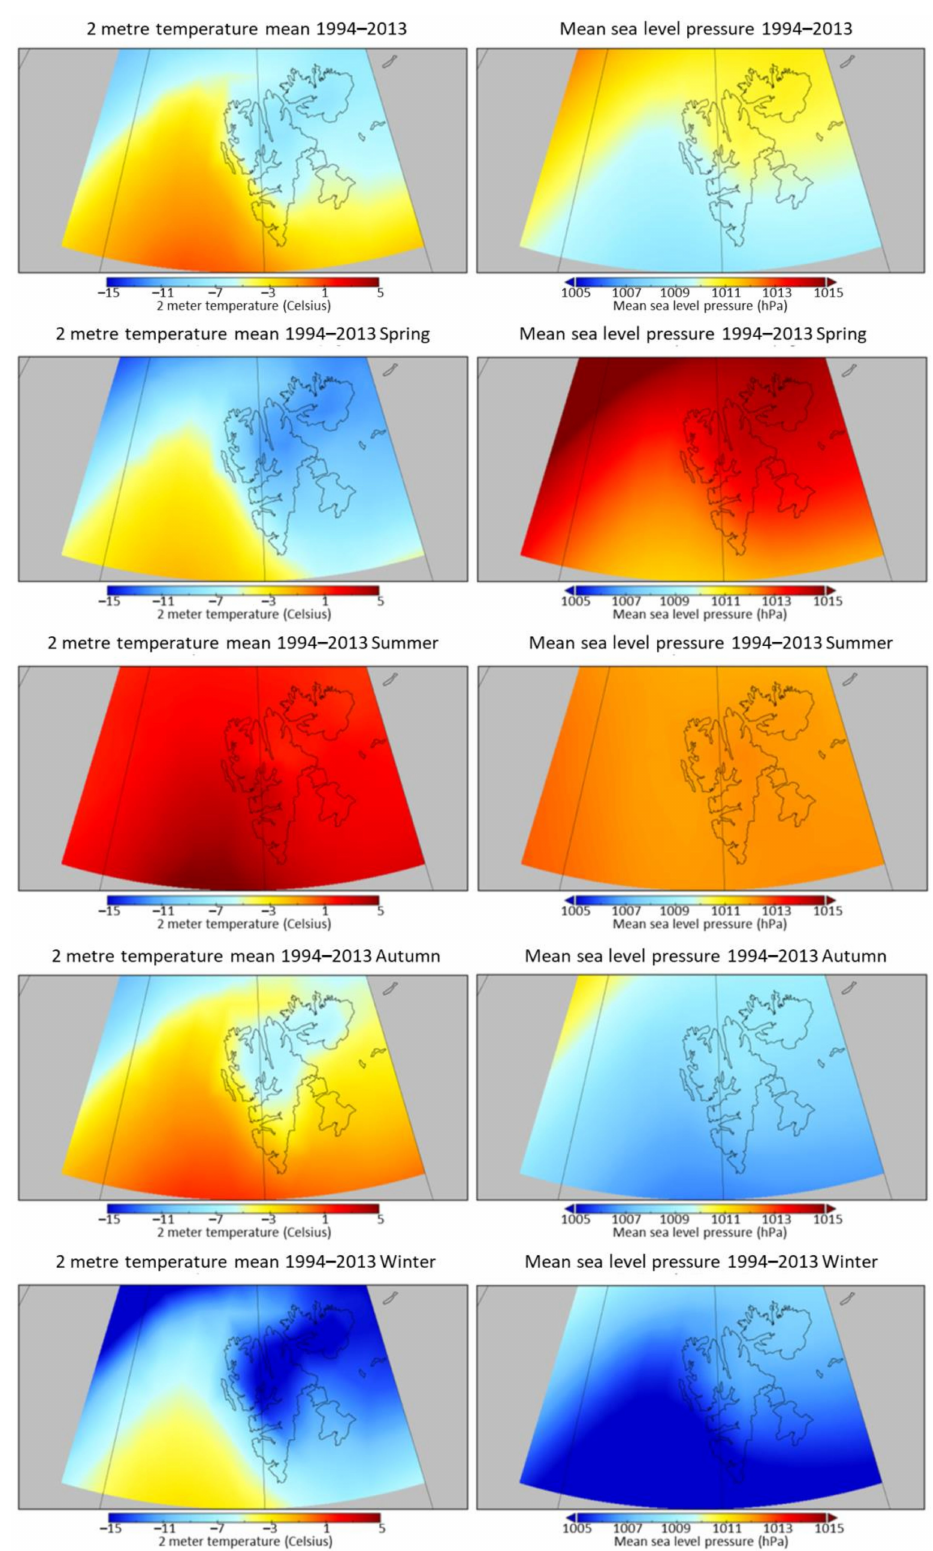
Figure 13. Distribution of mean 2 m temperature (top left panel) and mean sea level pressure (top right panel) in Svalbard region from 1994 to 2013 and below the distributions in the following seasons—spring, summer, autumn, and winter. Data derived from Era-Interim